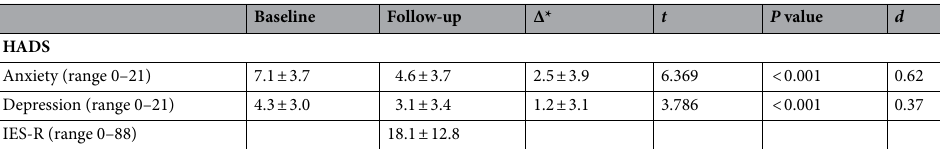
Table 2. Anxiety and depression, and the psychological impact of COVID-19 in study participants. Data are mean ± standard deviation. *Delta was calculated from the difference between the baseline and follow-up mean scores of anxiety and depression. α ≤ 0.05 indicates significant difference. Cohen’s d was reported as indicator of effect size from the paired samples t